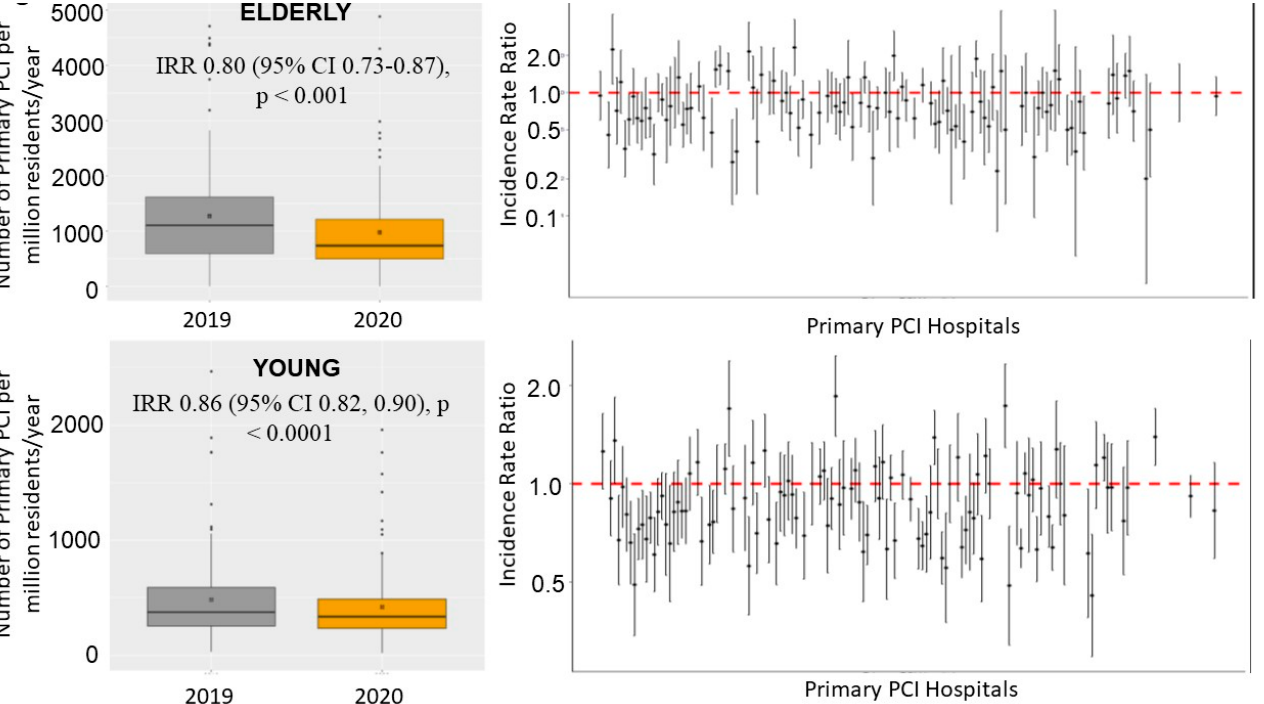
Figure 1. Box–and–whisker plot (on the left) showing the number of STEMI patients treated by mechanical reperfusion per million inhabitants/year in 2019 and 2020. The right graph shows the incidence rate ratio with 95% confidence interval across each center.